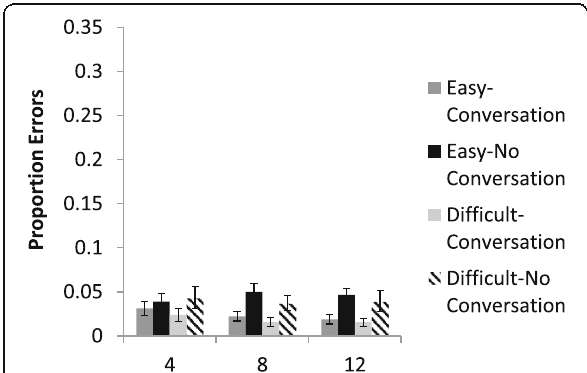
Fig. 6 The proportion of errors across set size for each condition in experiment 2. Error bars represent the standard